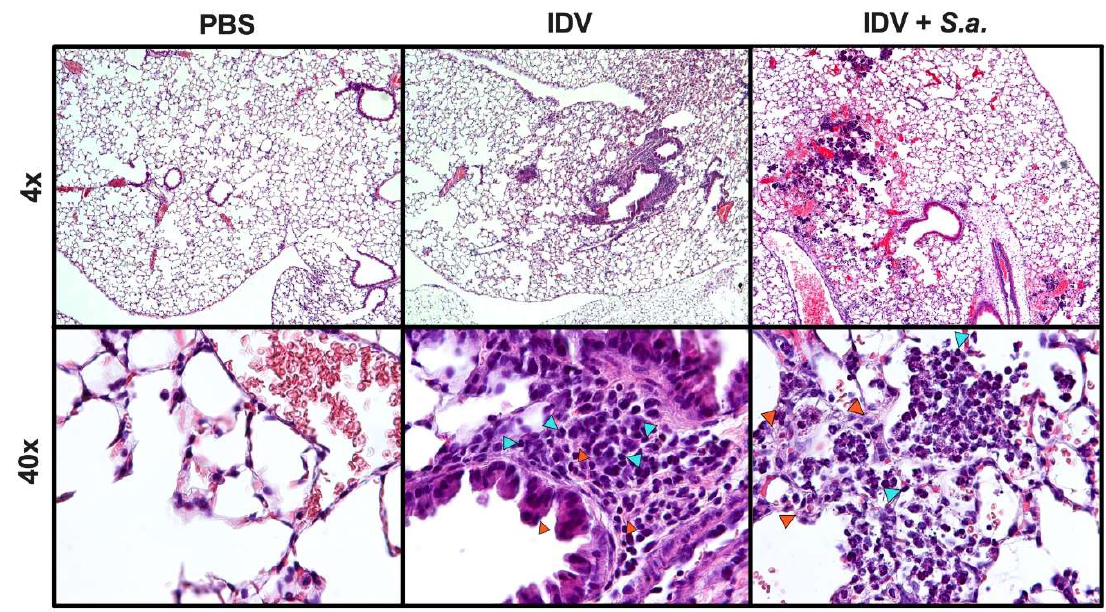
Figure 2. Histological analysis of primary influenza D virus (IDV) infection and subsequent bacterial infection in C57BL / 6 wildtype (WT) mice. C57BL / 6 (WT) mice were inoculated with OK11 (IDV) or PBS on day 0 or challenged with S. aureus on day 7 post-IDV. Representative images of H&E stained lung sections are shown at 4 × and 40 × objective magnification. Examples of edema are demonstrated by orange arrow heads and neutrophils by blue arrow heads.